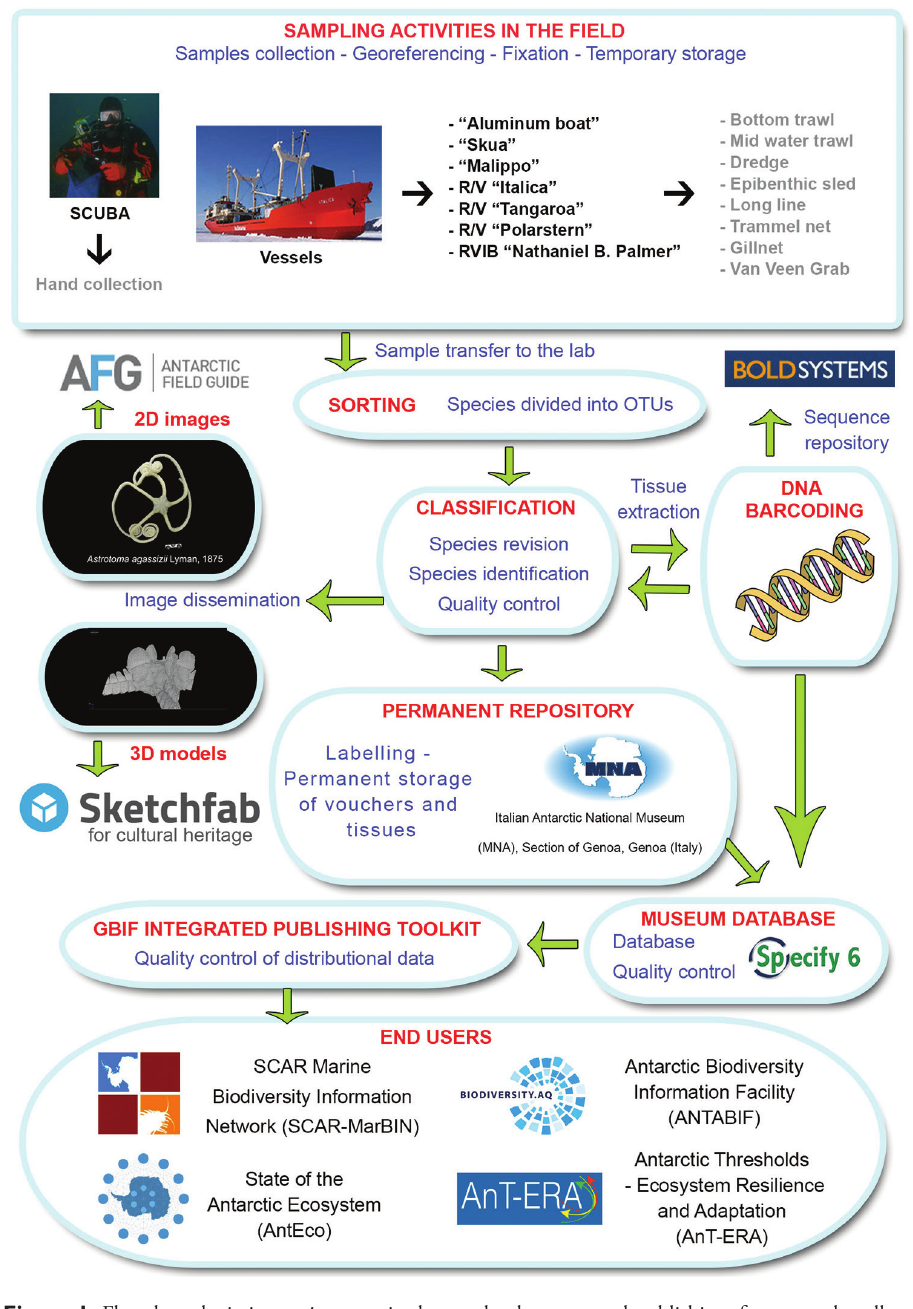
Figure 1. Flowchart depicting major steps in dataset development and publishing, from sample collec- tion to the production of a virtual collection of the museum’s 3D